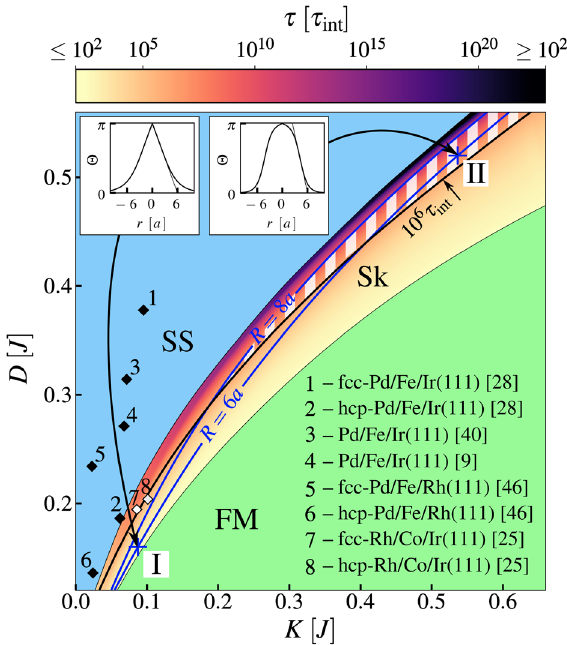
Fig. 1 Magnetic phase diagram for a monolayer of magnetic moments on a hexagonal lattice. A spin spiral is the ground state of the system in the SS region (blue), while the ferromagnetic state is the only stable con fi guration in the FM domain (green). Metastable, isolated skyrmions in the FM background exist in the Sk sector. The color scheme (see top bar) shows the calculated HTST lifetime of isolated skyrmions in terms of the intrinsic precession time τ int = μ ( J γ ) − 1 , which is on the order of femtoseconds for a typical magnetic system. A thermal energy of 2.6 J was assumed in the lifetime calculations. Some of the contours of equal skyrmion radius R and lifetime τ are shown with blue and black solid lines, respectively. Material parameter domain corresponding to skyrmions with R < 8 a and τ > 10 6 τ int is marked with hatching. Insets show skyrmion pro fi les and de fi nition of the skyrmion radius for the two points, marked I and II, lying on the same R -isoline. Black and white diamonds indicate effective material parameters for Fe- and Co- based ultrathin skyrmionic systems, respectively, which are listed in the legend. For ref. 25 , the parameters were extracted using the method described in Supplementary Note